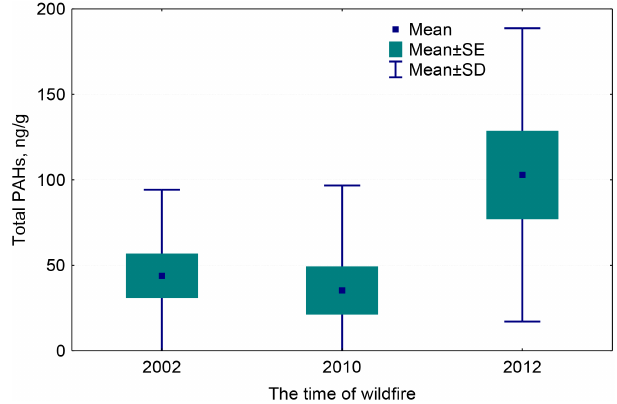
Figure 13. The categorized box and whisker plot for total PAHs in horizons Hpir, Apir, O and Cpir of soils affected by the fires of 2002, 2010, and 2012 (pits 2, 3, 4, 5, 6, 7, 8, 9, 11, and 12). The number of sample replicates: 2002 year -15, 2010 year -19, 2012 year